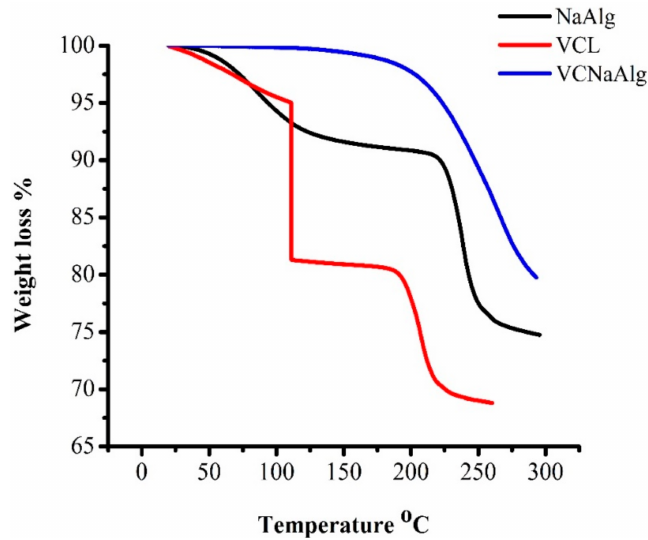
Figure 4. Thermogravimetric analysis of pure NVCL, pure NaAlg, and bare chemically grafted Poly (NVCL- g -NaAlg) in situ depot gel sample.